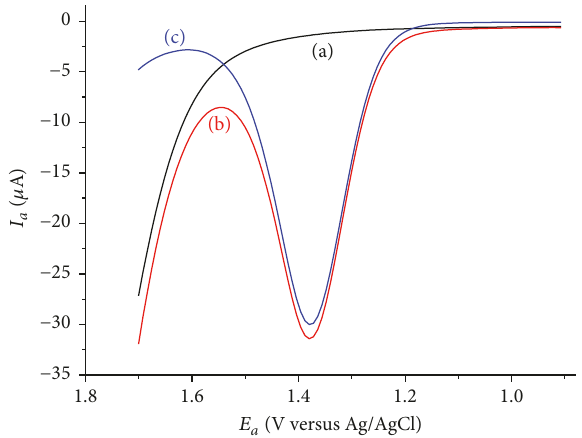
Figure 7: DPVs of LGCE in pH 4.0 ABS containing various concentrations of caffeine ((a)–(j): 6, 8, 10, 20, 30, 40, 50, 60, 80, and 100 𝜇 M, resp.). Inset: plot of anodic peak current versus concentration of